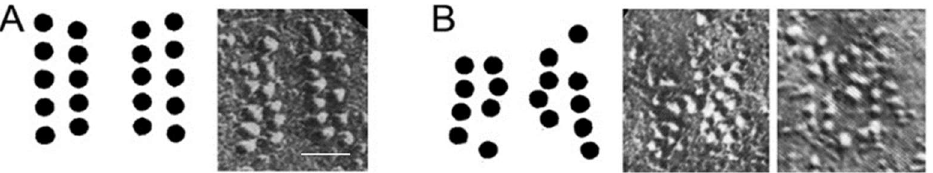
Figure 3. Freeze fracture of control and LEMS NMJs AZs showing AZ disruption after LEMS passive transfer to mice. ( A ) Representative control mouse AZ organization (left: diagram, right: freeze fracture replica, scale = 50 nm). ( B ) Representative LEMS-modified AZ organization (left: diagram of protein organization, right: two example AZs from nerve terminals of mice passively transferred with LEMS serum) Adapted from Nagel et al. [75]; Fukuoka et al. [10]; Fukunaga et al. [9].